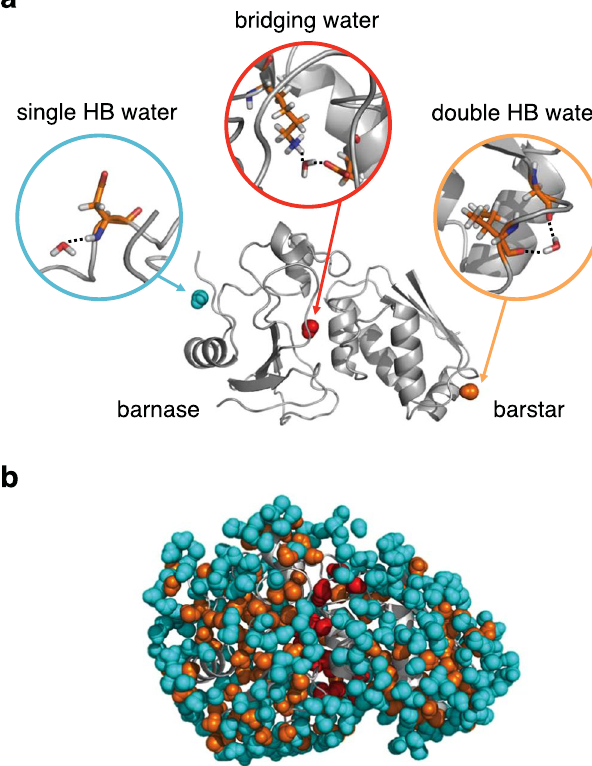
Figure 2. ( a ) Illustration of single HB, double HB, and bridging waters; dotted lines denote hydrogen bonds. ( b ) Snapshot of the barnase–barstar complex structure with hydration water, showing the distribution of single HB water (cyan), double HB water (orange), and bridging water (red).